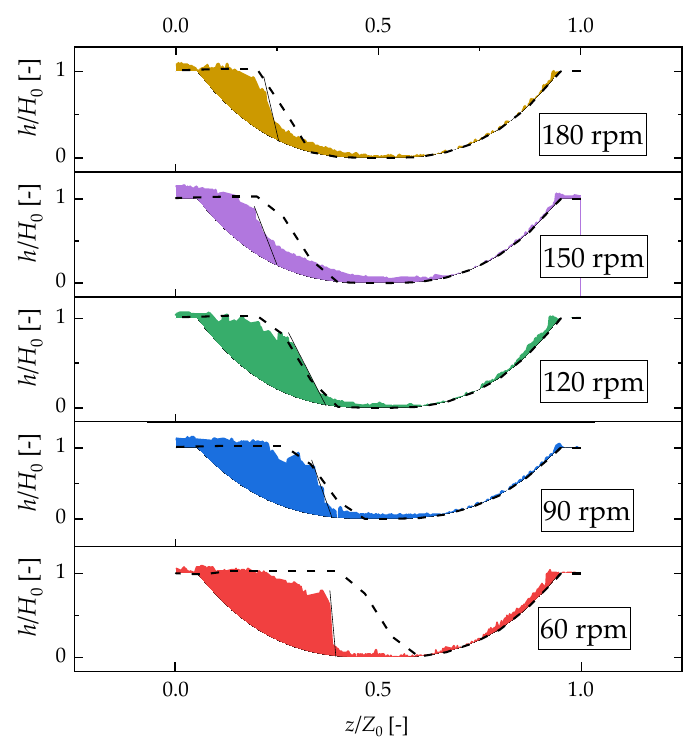
Figure 9. Effect of screw rotation speed on the resin distribution of the experimental and simulation results. The dotted lines show the simulation results and the experimental results are filled with colors.